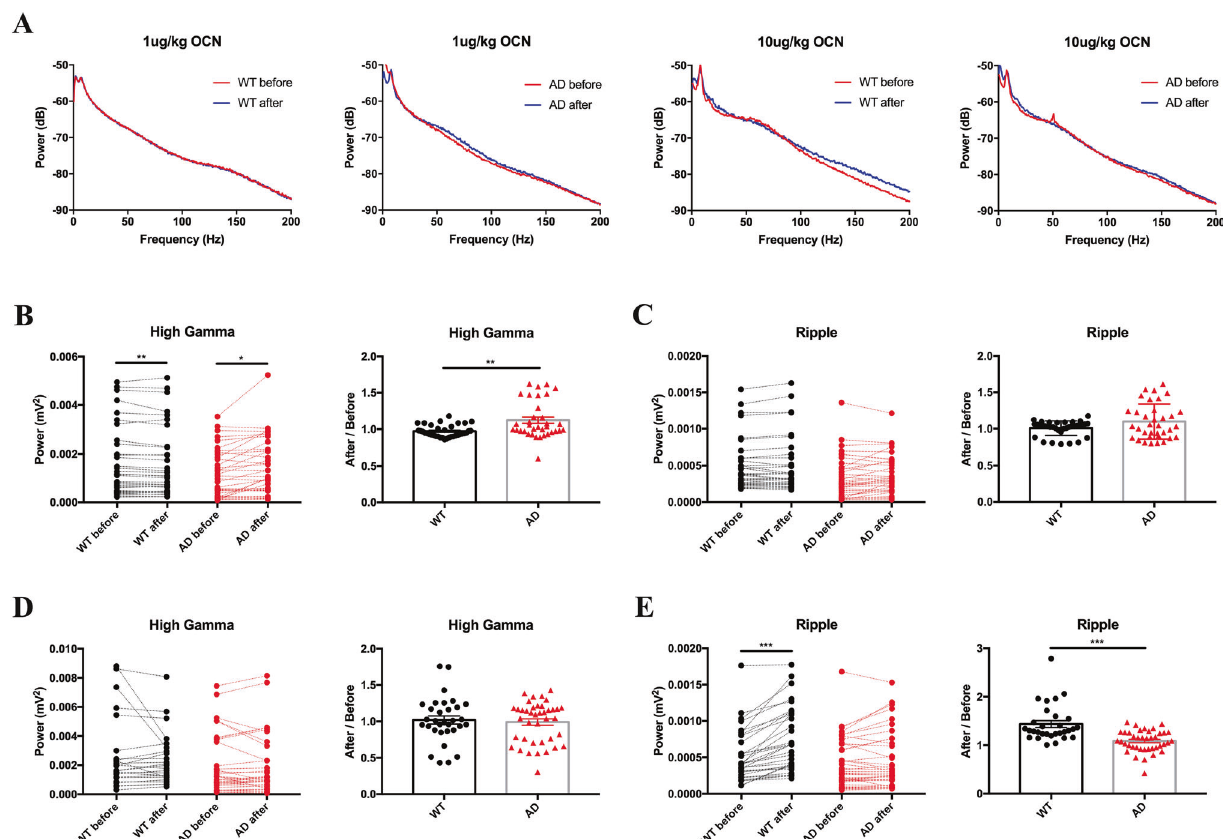
Fig. 3 OCN altered the LFP power in the mPFC. A 1 μ g/kg OCN altered the LFP power at 0 – 200 Hz bands in AD mice, while 10 μ g/kg OCN altered the LFP power in WT mice. B 1 μ g/kg OCN increased the LFP power at High gamma (55 – 90 Hz) band both in WT and AD mice. Oscillations of High gamma band were higher in AD mice than WT mice after 1 μ g/kg OCN treatment. C 1 μ g/kg OCN did not affect the LFP power at Ripple band (100 – 200 Hz). D 10 μ g/kg OCN did not affect the LFP power at High gamma band. E 10 μ g/kg OCN increased the LFP power at Ripple band in WT mice. Oscillations of Ripple band were higher in WT mice than AD mice after 10 μ g/kg OCN treatment. n = 5 per group. A P -value < 0.05 was considered to be statistically signi fi cant by paired t test when comparing the difference between before and after OCN treatment, unpaired t test when comparing the difference between WT group and AD group. ** P < 0.01, *** P < 0.001. immunological functions of microglia [26]. In our present study, of neurons) with GFAP (marker of astrocytes) and Iba-1 (a marker OCN promoted glucose consumption as well as lactate production of microglia) in the hippocampus of mice. As shown in Fig. 4G, H, in BV2 cells (a cell line of microglia) (Fig. 6A, B). The glycolytic Gpr158 was mainly co-localized with astrocytes rather than stress test showed that OCN increased maximum glycolytic microglia and neurons. capacity in BV2 cells (Fig. 6C). Mitochondria stress test showed that OCN did not change OXPHOS in BV2 cells (Fig. 6D). The mRNA OCN-enhanced glycolysis in astrocytes and microglia levels of Ldha were upregulated while that of Pdk1 were not Metabolic dysregulation is one of the major pathological affected (Fig. 6E). Protein levels of Pdk1 and Ldha were elevated of changes in AD [8, 22]. A β activates the astrocytes and impairs a marginal signi fi cance ( P = 0.086 and P = 0.086, respectively) (Fig. its energy metabolism mainly characterized by a decrease in 6F, G). glycolysis [23]. Here we found that 50 ng/ml to 200 ng/ml OCN Apart from astrocyte and microglia, we also tested the effect of signi fi cantly increased the glucose consumption of C8D1A cell (a OCN on neurons. OCN increased glucose consumption in HT22 cell line of astrocytes) (Fig. 5A). Furthermore, lactate concentra- cells (Fig. S3A) while lactate production (Fig. S3B), ECAR in tions in culture medium, representing the glycolytic activity of glycolysis stress test (Fig. S3C), and OCR in mitochondria stress test cultured cells, were elevated in OCN-treated C8D1A cells (Fig. (Fig. S3D) were not signi fi cantly changed by OCN treatment. 5B). As the maximum lactate concentration was reached when 100 ng/ml OCN was administrated, we used this concentration Ablation of GPR158 blocked the effect of OCN on glycolysis in for further experiments. Using Seahorse real-time metabolic astrocytes analyzer, we found that OCN promoted maximum glycolytic It is reported that Gpr158 is the receptor responsible for the capacity in C8D1A cells (Fig. 5C). Meanwhile, OXPHOS was cognition-regulatory function of OCN [16]. As described above, we unaffected by OCN (Fig. 5D). Pdk1 is a key enzyme increasing found that Gpr158 is also expressed in astrocytes and microglia, glycolytic fl ux and Ldha is the key enzyme in lactate production however, it is unknown if OCN improves glycolysis through [24, 25]. OCN upregulated Pdk1 at both mRNA and protein levels Gpr158. We interfered Gpr158 expression by virus-delivered while upregulated Ldha protein level of a marginal signi fi cance shRNA in C8D1A cells and the Gpr158 protein was downregulated by 56% (Fig. 7A, B). The positive effect of OCN on glucose consumption and lactate production was abolished in Gpr158 Cell Death Discovery (2023)